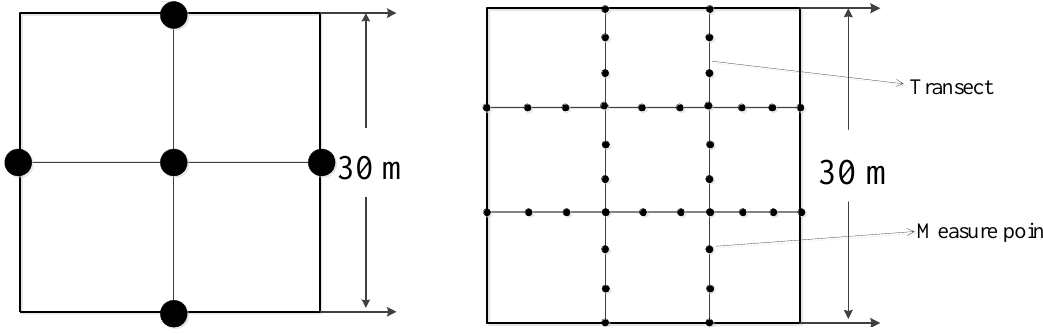
Figure 2. Field campaign sampling strategy for each ESU ( left : LAI measurement; right : spectrum